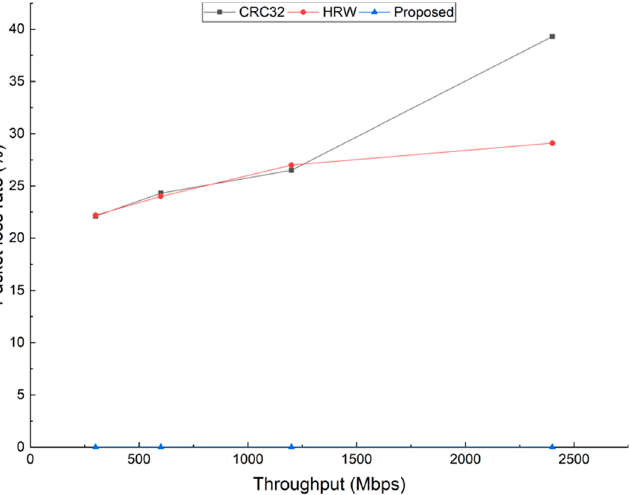
Figure 4. Packet loss rates under different throughputs when one core is overloaded while others have no traffic.